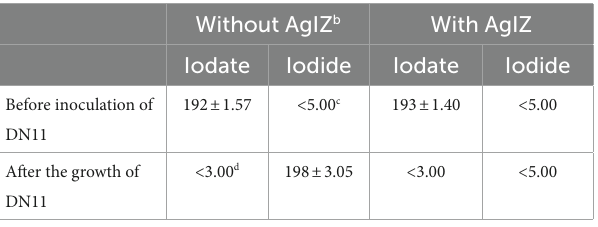
TABLE 2 Removal of iodine from the growth medium of strain DN11 by silver-impregnated zeolite a